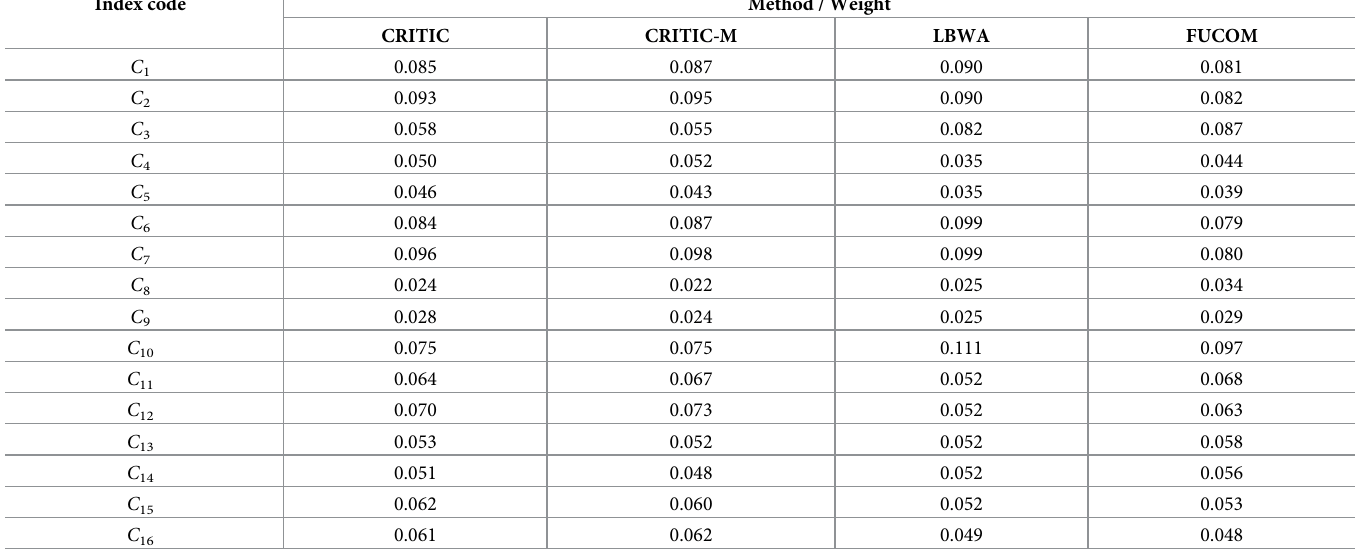
Table 8. Weights calculated by the four